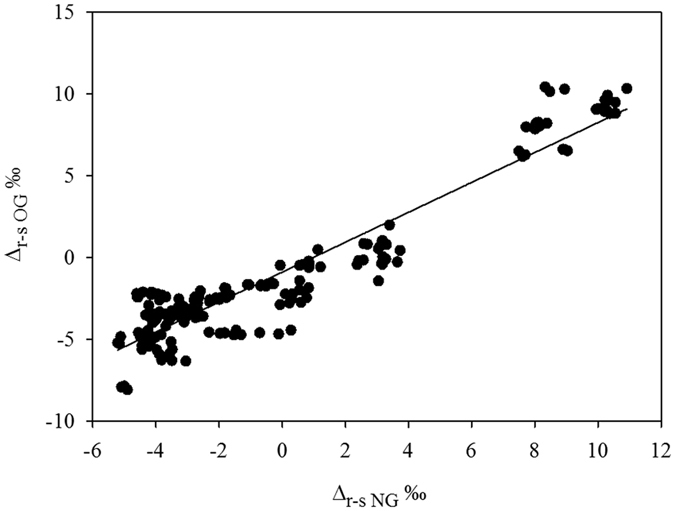
The linear regression of the difference interval between δ13Croot and δ13Csoil at over-grazed and non-grazed sites.Δr-sNG represents the difference interval of δ13Croot and δ13Csoil in non-grazed plots (Where Δr-sNG = Δroot-soil NG = δ13CrootNG − δ13CsoilNG (‰)), Δr-sOG represent the difference of δ13Croot and δ13Csoil in over-grazed plots (Δr-sNG = Δroot-soil NG = δ13CrootNG − δ13CsoilNG (‰)).